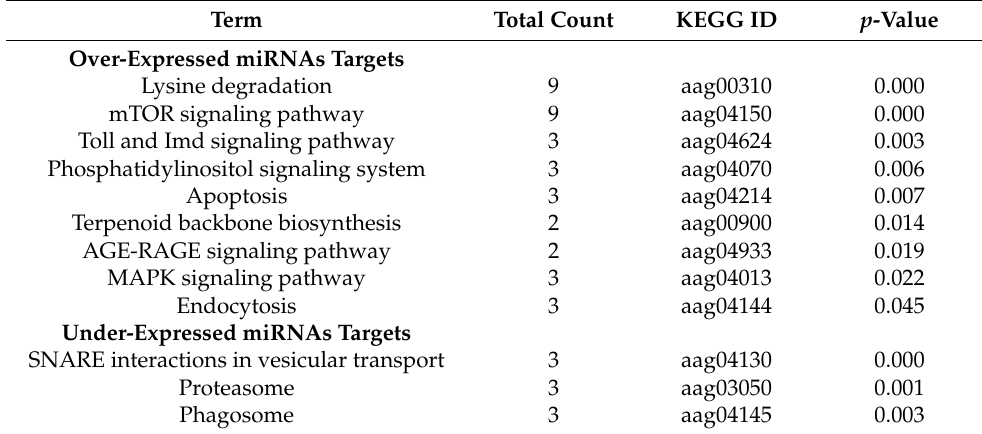
Table 3. Biological pathways affected by differentially accumulated miRNAs. Biological pathways based on the Kyoto Encyclopedia of Genes and Genomes (KEGG) database of transcripts identified as targets of differentially abundant miRNAs. The list of target transcripts was obtained by KEGG Orthology Based Annotation System (KOBAS) gene-list enrichment